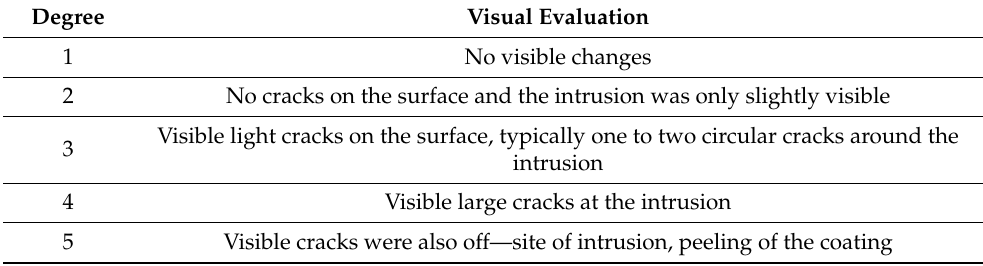
Table 2. Impact resistance: degree and Table 2. Impact resistance: degree and evaluation . Table 2. Impact resistance: degree and evaluation . Table 2. Impact resistance: degree and evaluation . Table 2. Impact resistance: degree and evaluation . Table 2. Impact resistance: degree and evaluation .